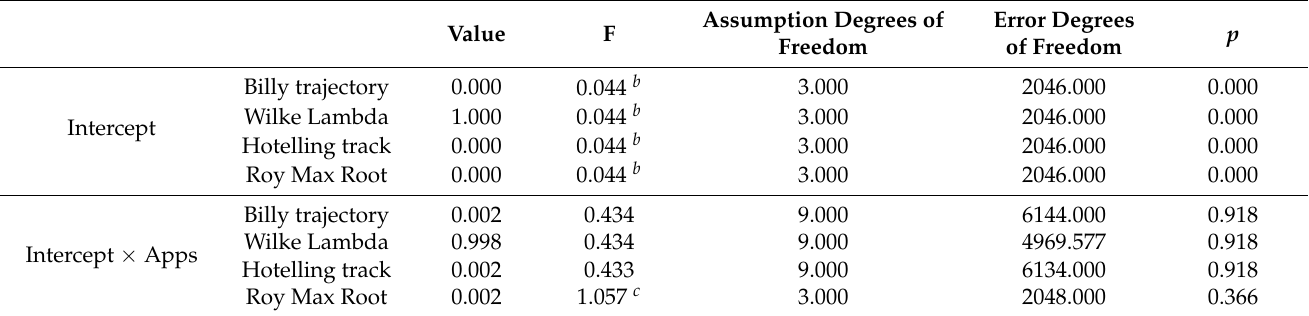
Figure 10 visualizes the trend of the wave amplitude with the change of brain